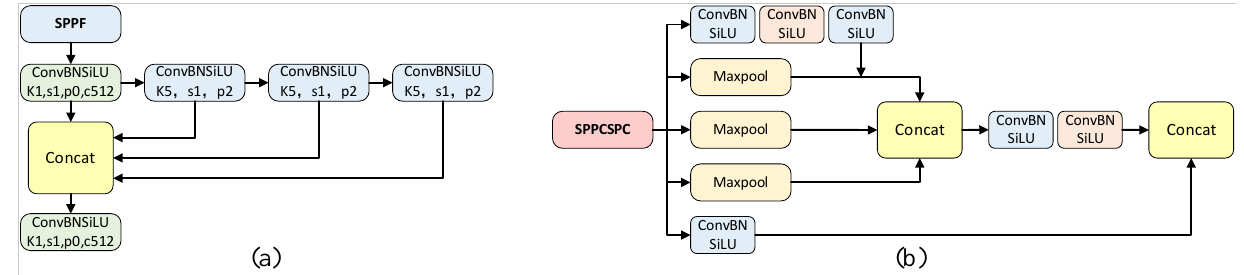
Figure 7. ( a ) Illustration of the architecture of the SPPF module. ( b ) Illustration of the architecture of the SPPCSPC module.